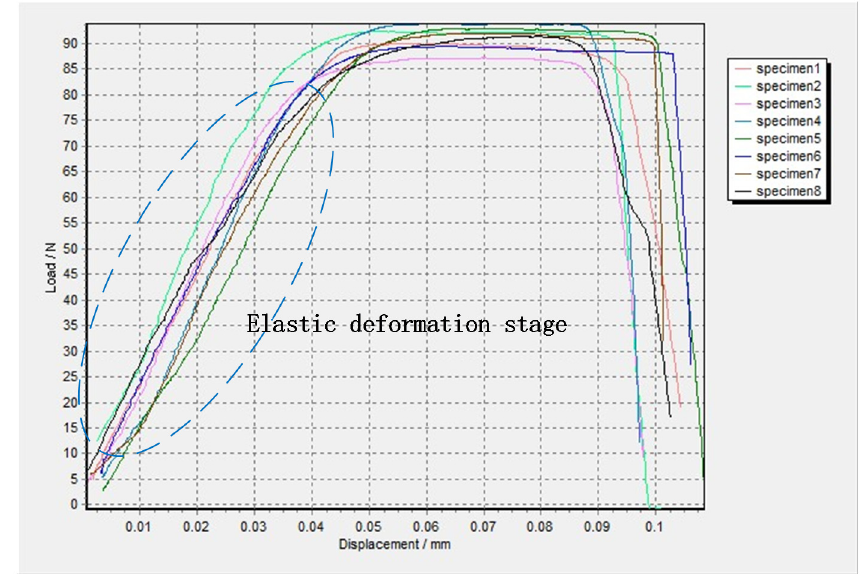
Figure 19. Displacement and load curve of specimens.